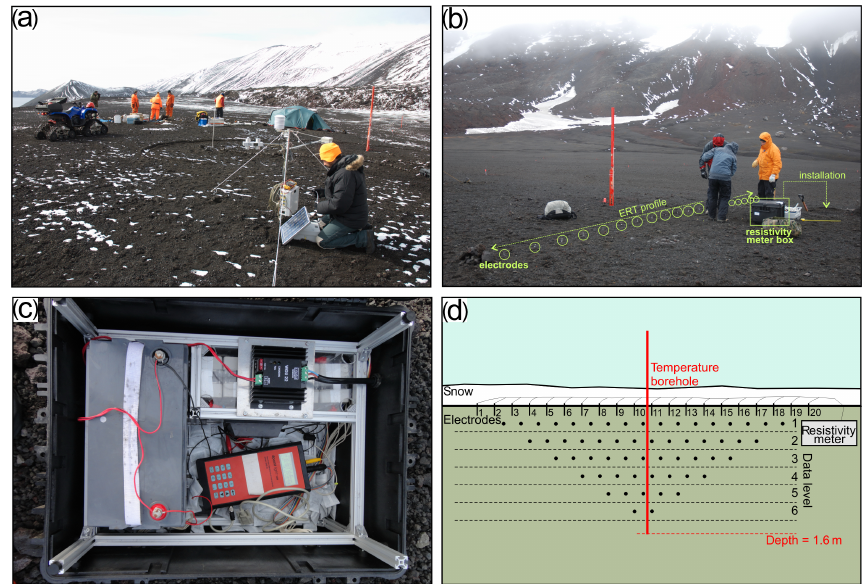
Figure 3. (a) Overview of the CALM-S site and (b) A-ERT monitoring system installation at CALM-S site. Electrodes are buried in the ground and are connected to the resistivity meter box by buried cables. (c) Resistivity meter box; the 4POINTLIGHT_10W instrument is connected to a solar-panel-driven battery and multi-electrode connectors . (d) A schematic display of the measured resistivity (pseudo- section) at the CALM-S site using a Wenner electrode